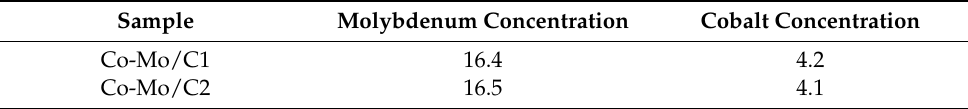
Table 8. Composition of